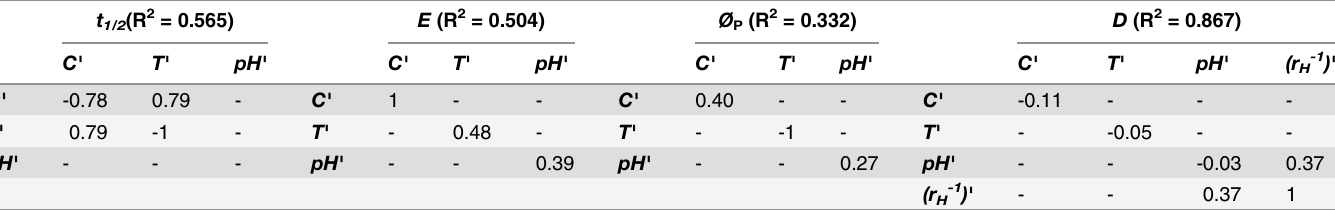
Table 2. Sensitivity of key hydrogel material properties to fabrication parameters. Sensitivities are obtained from the multiple regression coefficients, normalized to the largest coefficient in each model. The R 2 of the multivariate fit is indicated for each property. Analysis was performed on transformed (nondi- mensionalized) parameters. Only factors with p < 0.01 (ANOVA) are shown. t 1/2 (R 2 = 0.565) E (R 2 = 0.504) Ø 2 = P (R